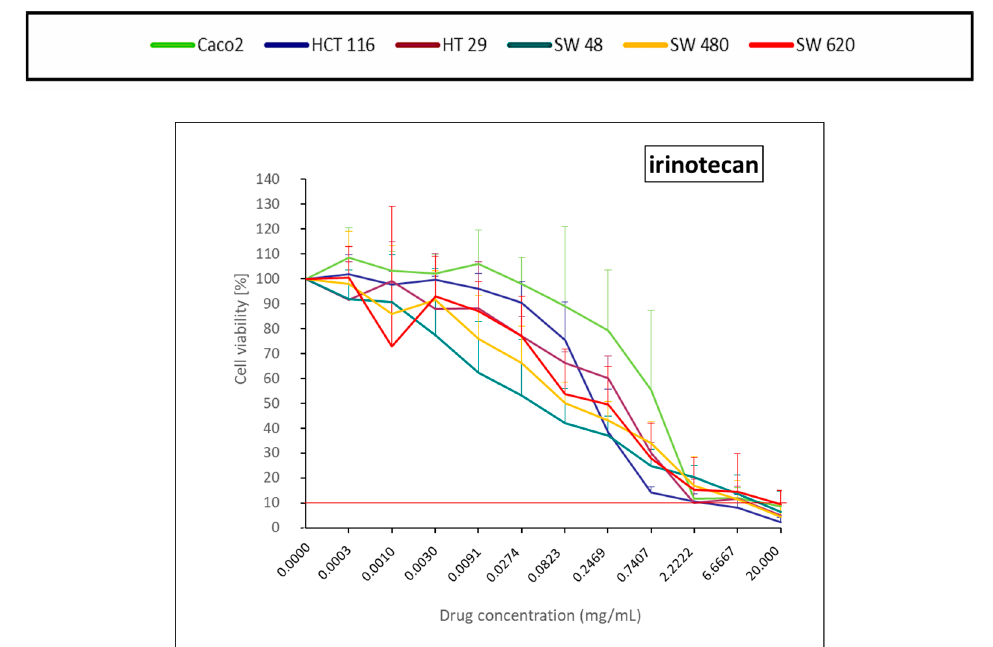
Figure 5. Colorectal cancer cell line viability curves (mean ± standard deviation) after a 30 min contact time with a DNA topoisomerase inhibitor (irinotecan). The horizontal red line represents 10% of cell viability. The results are presented after normalization with the control cells (untreated condition).